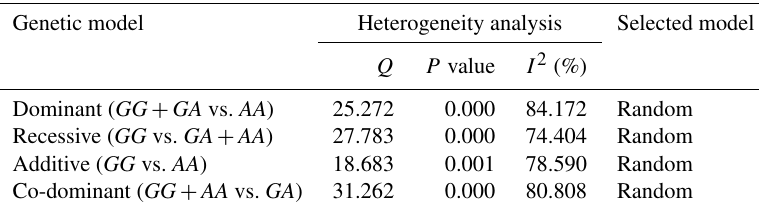
Table 2. The heterogeneity test results for genetic models. Genetic